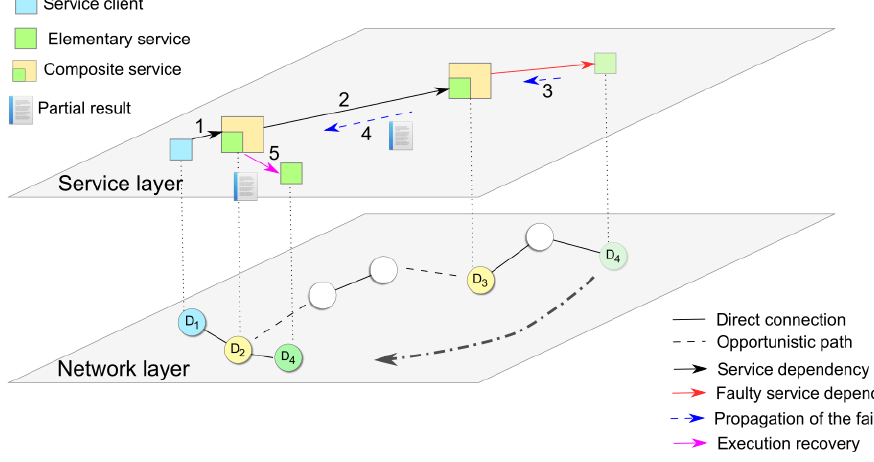
Figure 3. Illustration of a recovery